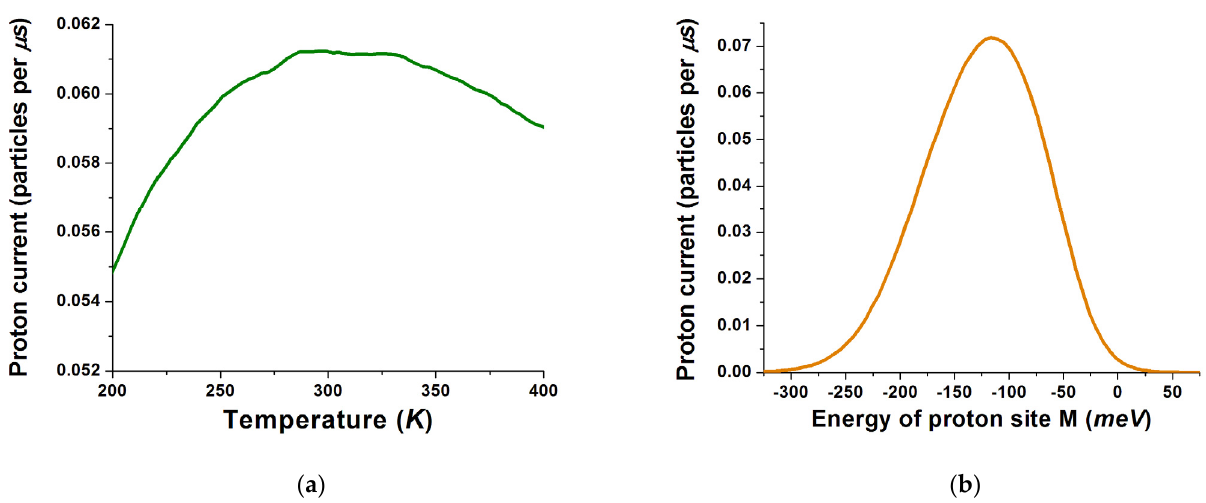
Figure 5. Proton-pumping current: ( a ) as a function of temperature; ( b ) as a function of the energy of the proton middle site.